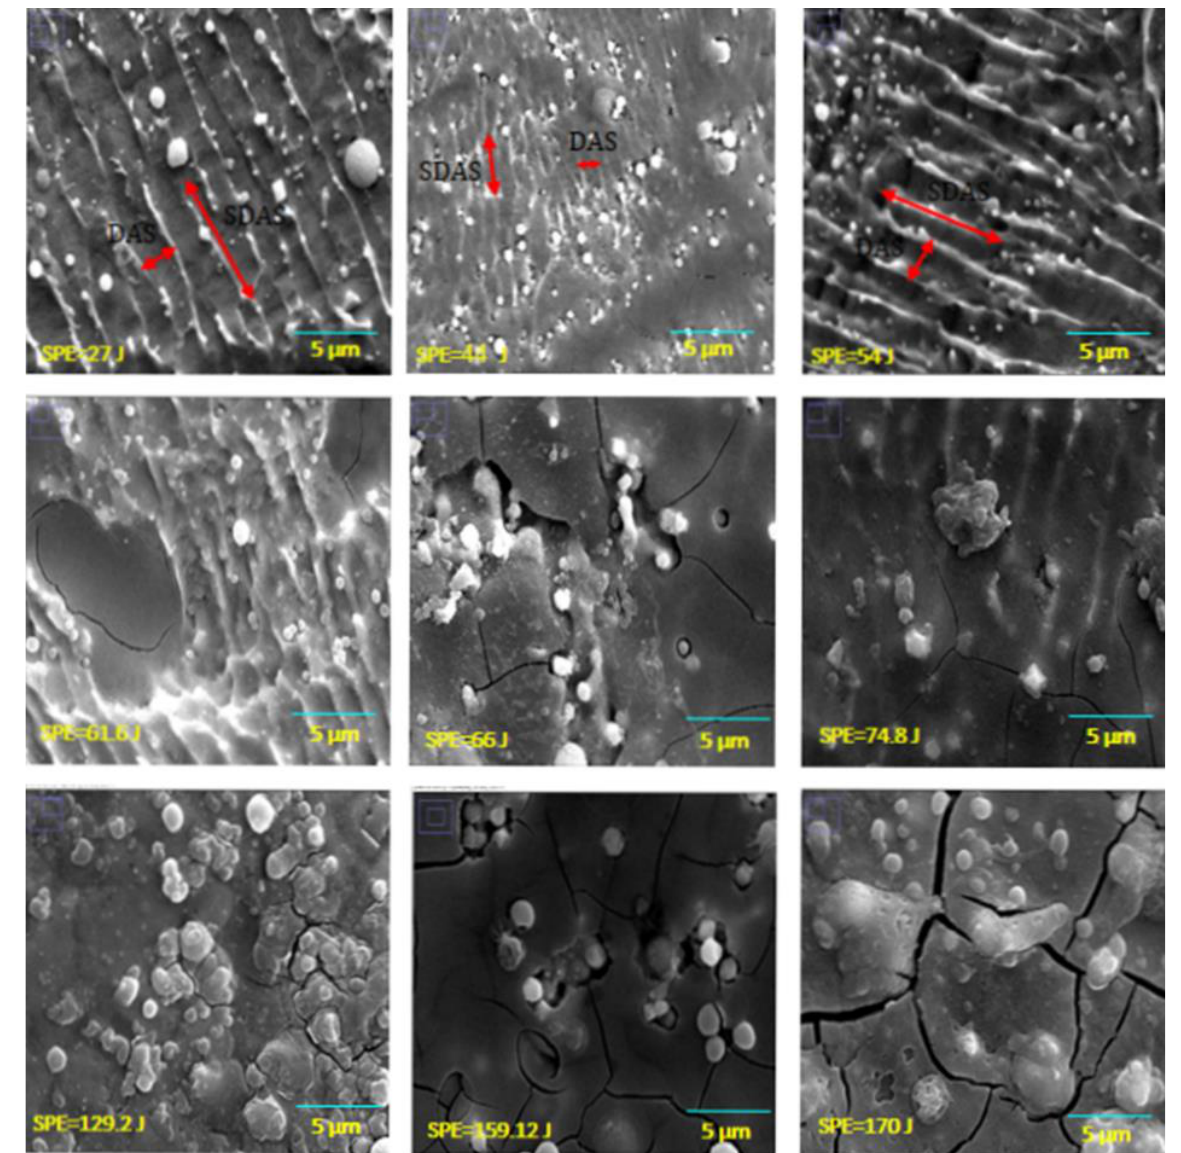
Figure 8. SEM images of the cross-section view of the 316L welded in serum.